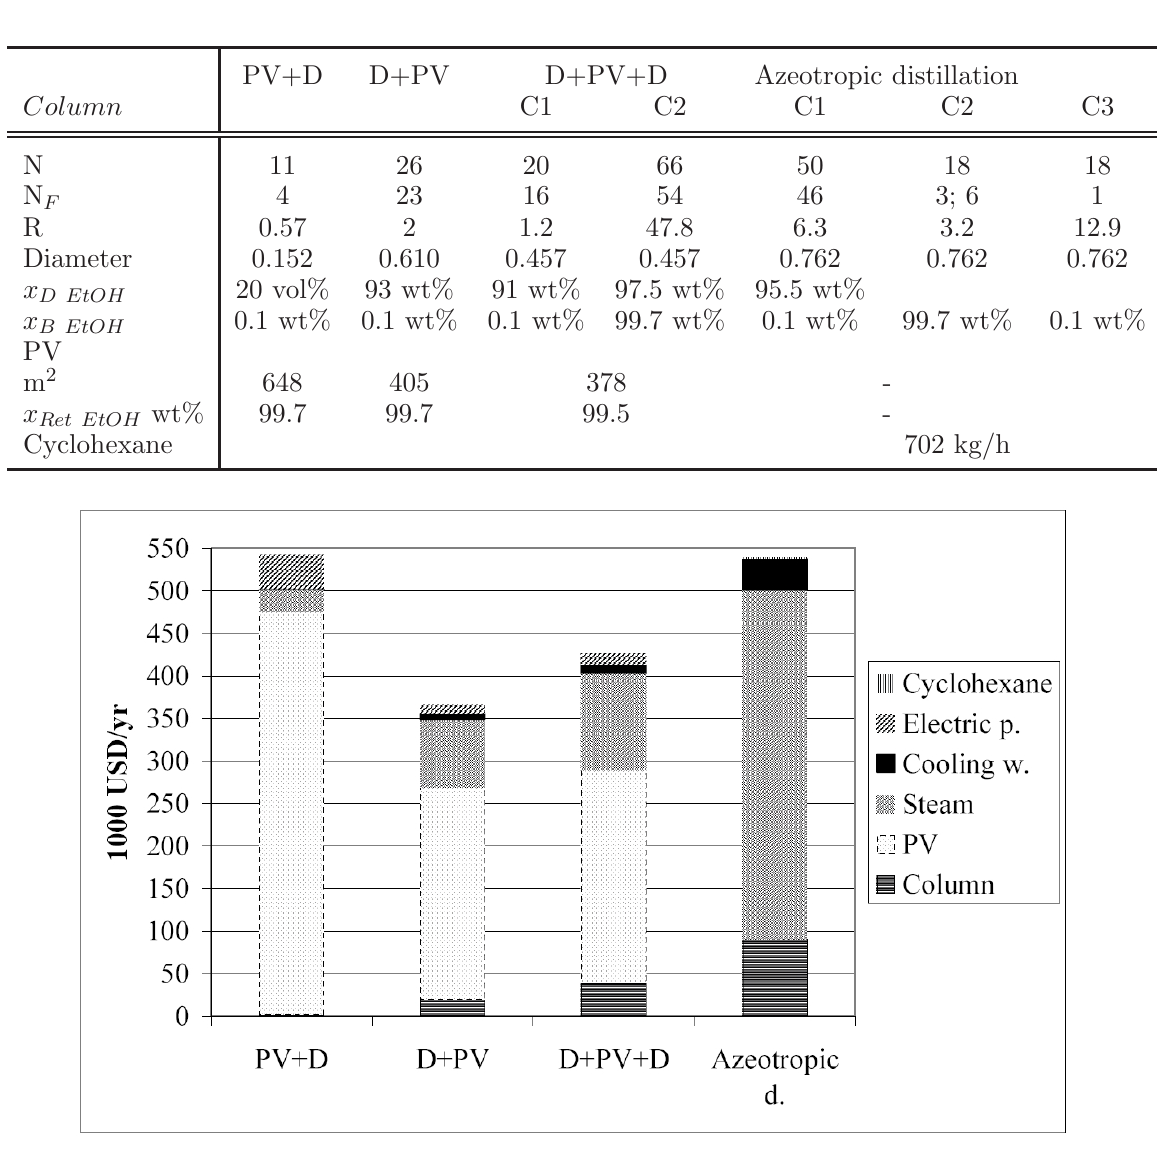
Fig. 13 Total annual cost with adiabatic